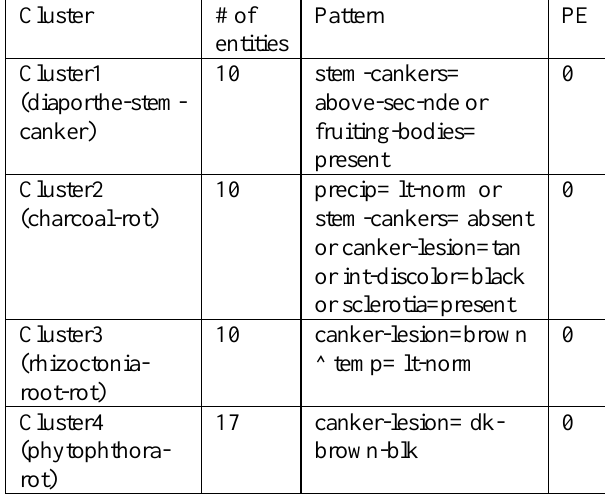
Table 4: Soybean disease characteristics